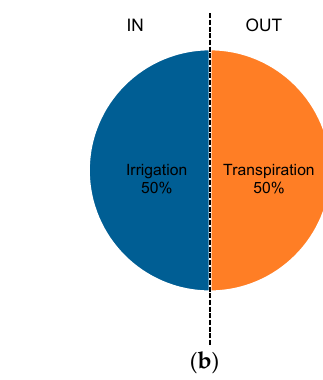
Figure 10. ( a ) Annual soil-based system in field conditions (SOIL-FIELD) water balance for the ten year simulation in Adelaide (Parafield) climate; ( b ) Annual hydroponic system in greenhouse condition (HYDRO-GH) water balance for the ten year simulation in Adelaide (Parafield) climate. Analysis of the cumulative difference between RAS effluent supply and irrigation demand over the simulation (Figure 11) shows the impact of different crop patterns in SOIL-FIELD and HYDRO- GH Scenario 1 (full reuse). A divergence becomes apparent around 2015, leading to a difference of approximately 1.0 mL by the end of the simulation, − 230 kL for SOIL-FIELD and 763 kL for HYDRO- GH; both within the ±1.0 mL from the initial volume model constraint.